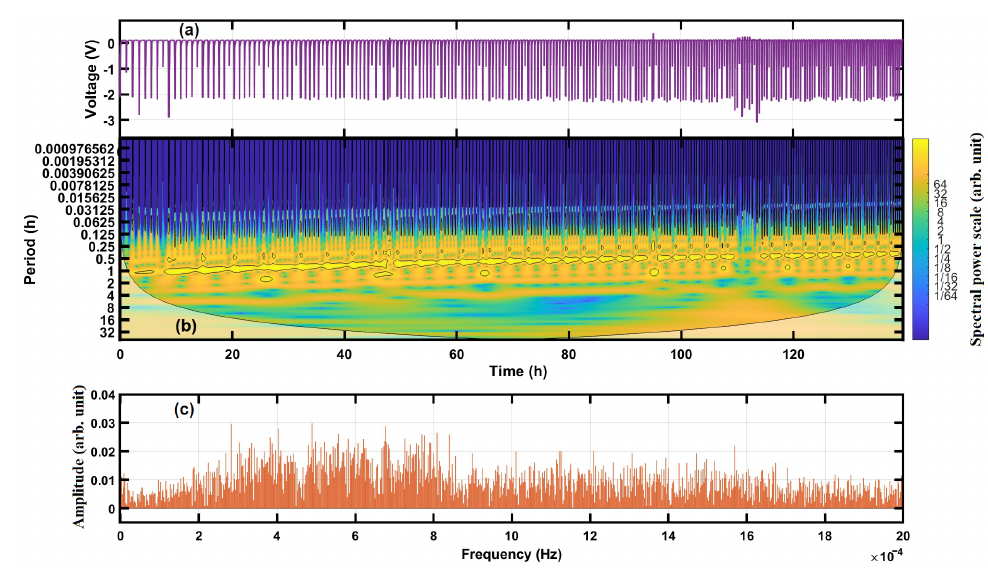
Figure 5. ( a ) Voltage, ( b ) wavelet spectral power, and ( c ) Fourier spectrum of the cycling test performed by NASA-PCE to commercial lithium-ion cells (C-LIC3). It was not possible to differentiate the frequencies before and after the failure.